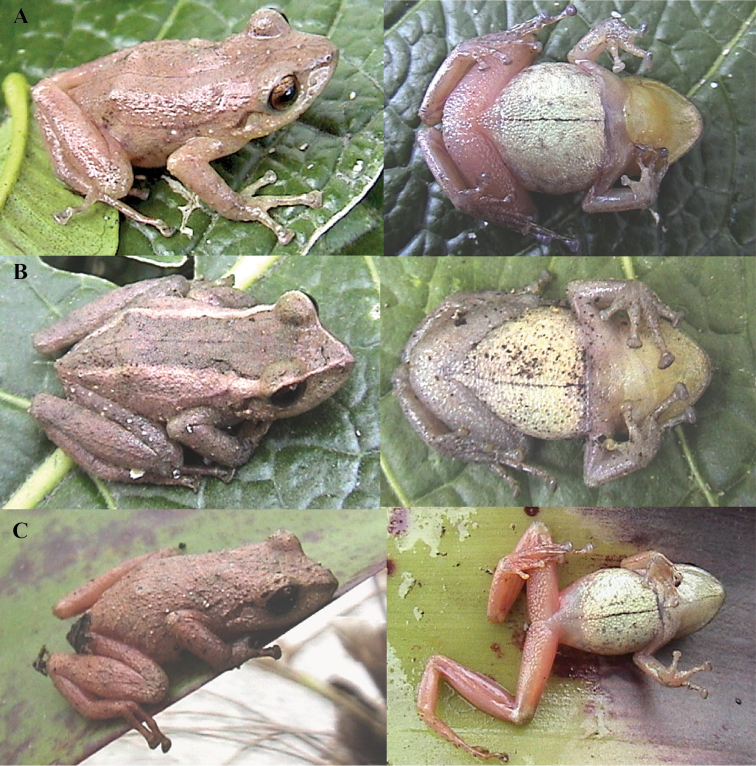
Color variation in live individuals of Pristimantis
totoroi sp. nov. AQCAZ 16718 (male, SVL 24.7 mm) BQCAZ 16721 (male, SVL 24.1 mm) CQCAZ 16725 (juvenile female, SVL 23.7 mm). Dorsolateral view on the left, ventral view on the right.